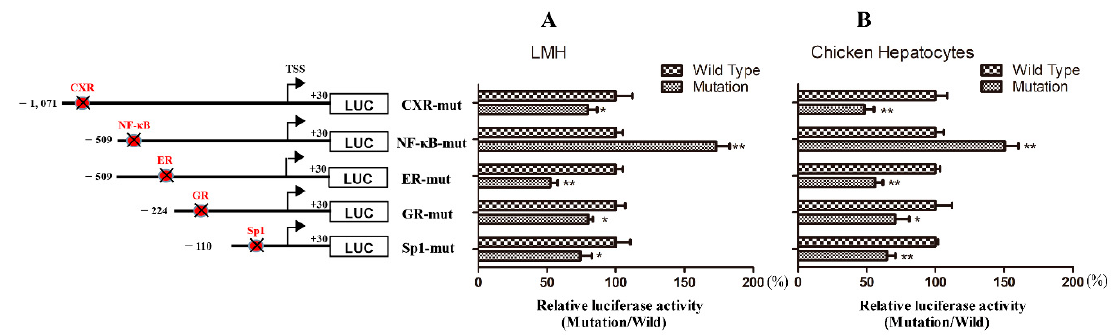
Figure 3. Site-directed mutagenesis analysis of the chicken Abcg2 promoter activity. Five mutation promoter constructs were transfected into ( A ) LMH cells and ( B ) chicken hepatocytes and assayed for luciferase activity. The left figure shows the schematic diagrams of the truncated promoters and the right graph shows the corresponding luciferase reporter assay results. The results are presented as the normalized relative luciferase activity levels (mutation / wild-type). * represents p < 0.05 and ** represents p < 0.01.